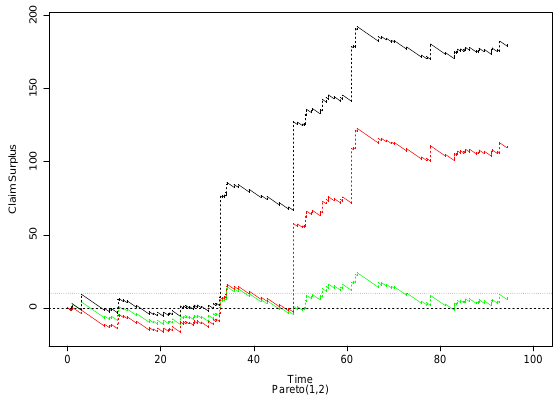
Figure 2. Sample paths of the insurance risk processes without reinsurance (black line), with LCR reinsurance (red line), and with EOL reinsurance (green line), for a Pareto(1,2) claim distribution. The company’s initial reserve is u = 10, the safety loading is θ = 0.1, expected claim size is µ = 2, claim arrival rate is λ = 1, and each time unit is 0.01 year = 3.65 days. For comparability between the two schemes, the retention level L for the EOL scheme is chosen so that the expected values of the LCR and EOL aggregate claims are equal at maturity time T =